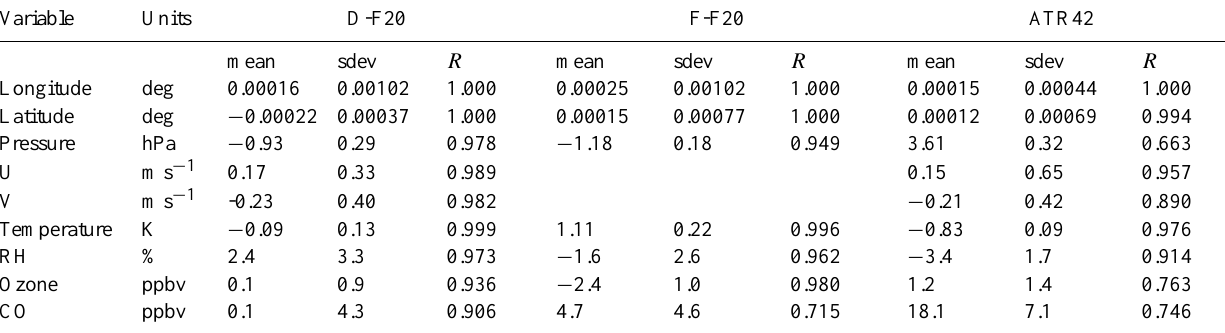
Table 4. Results from comparison flight legs in formation with BAe-146. For each aircraft, the difference from the BAe-146 measurement is summarised by its mean, standard deviation and rank correlation ( R ). A running median filter with a window width of 10s was applied to all data before putting on common time-base.